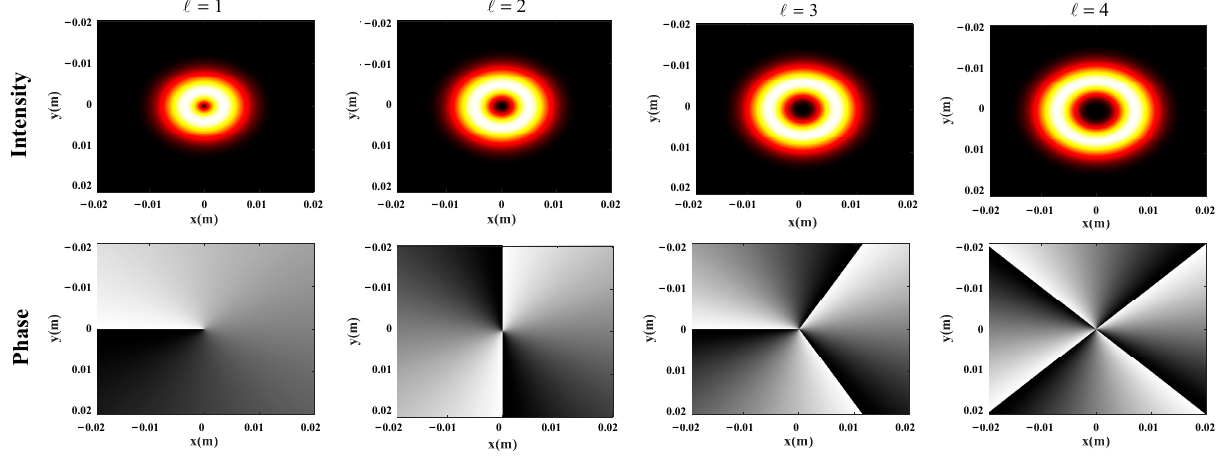
Figure 2. Intensity and phase distribution of the LG beam (at the